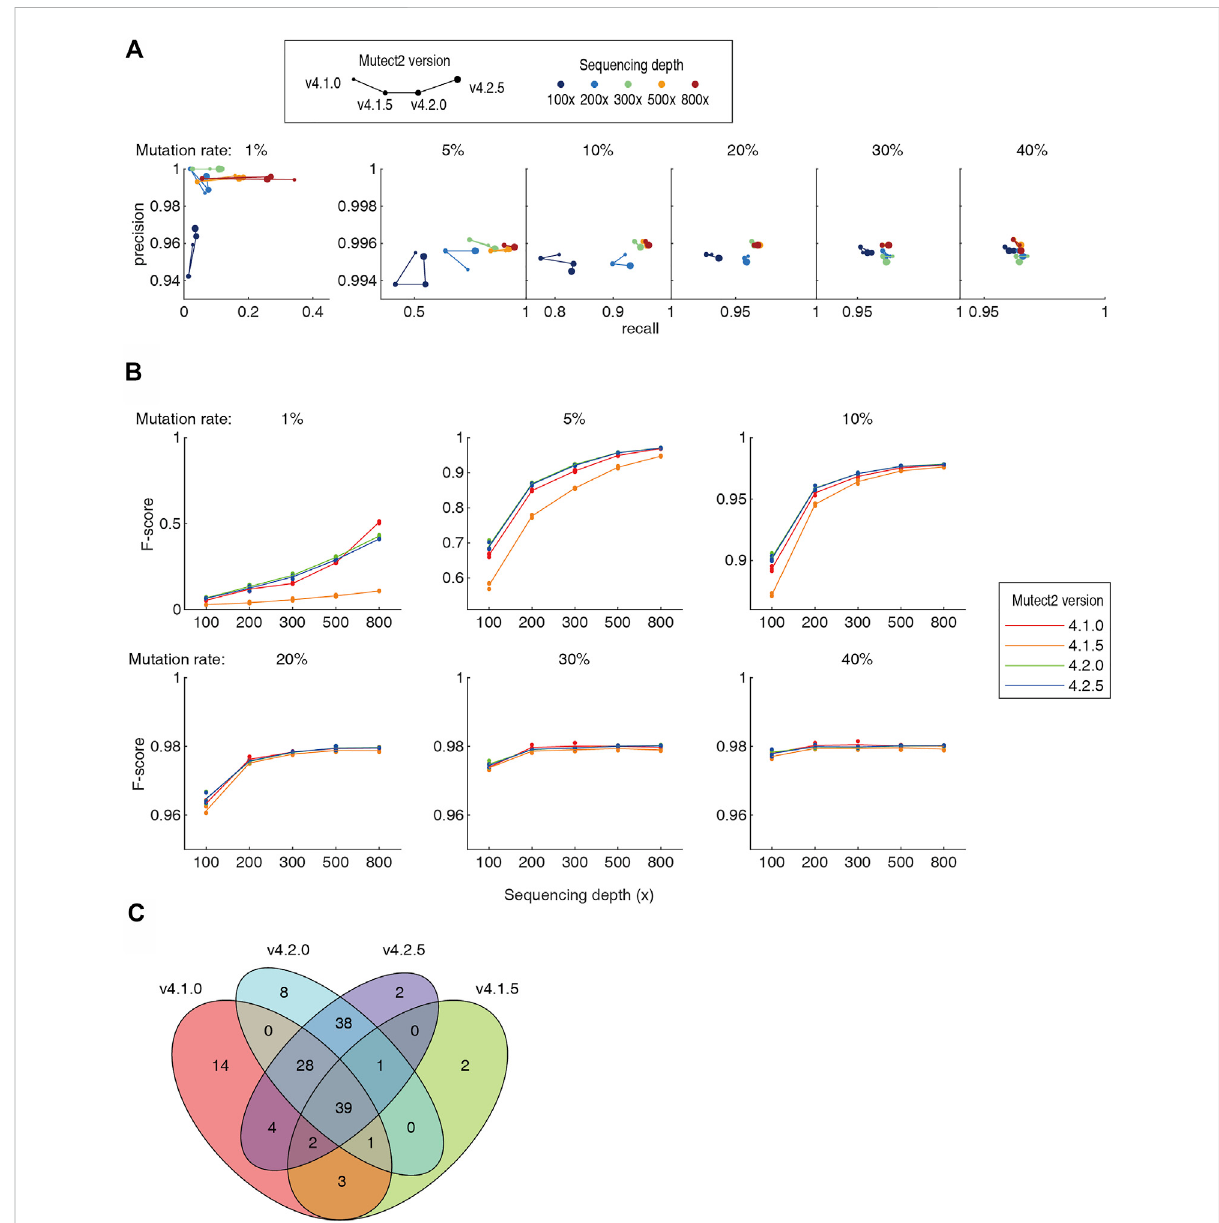
FIGURE 4 Comparison of four versions of the Mutect2. Detailed numbers were listed in Supplementary Table S1. (A) The precision-recall diagram of Mutect2 v4.1.0 to v4.2.5. The size of dots indicates the version, and the color indicates the sequencing depths. For each sequencing depth and each mutation rate, only one dataset was chosen to make the diagram for visibility. (B) The F-scores of the four versions of the Mutect2. (C) The Venn diagram of the somatic mutations detected by four versions of the